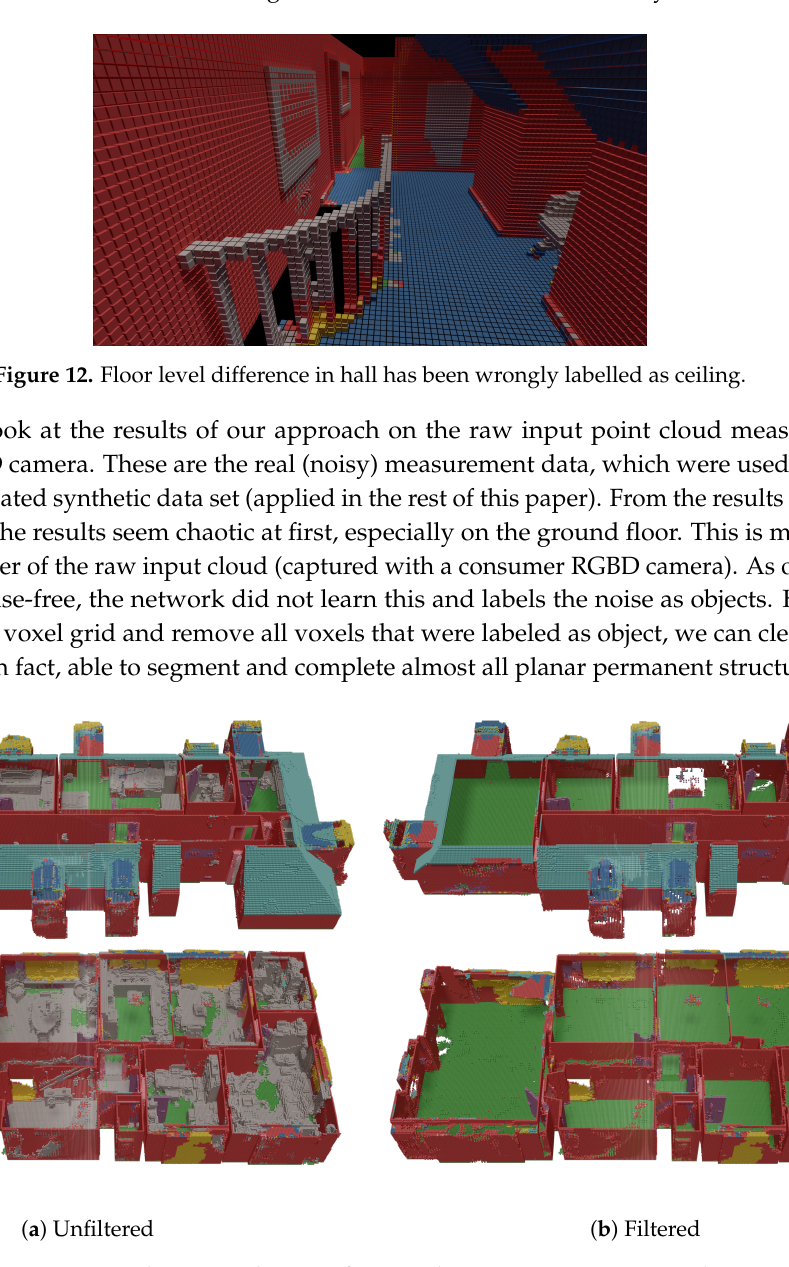
Figure 13. Qualitative evaluation of our implementation on raw input